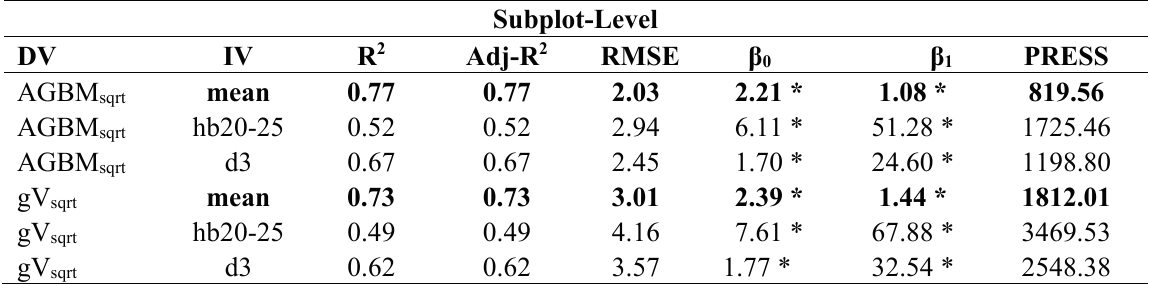
Table 7. Summary of the best subplot-level aboveground biomass and gross volume simple linear regression models for each point cloud metric set. * indicate p -values of less than 0.05.